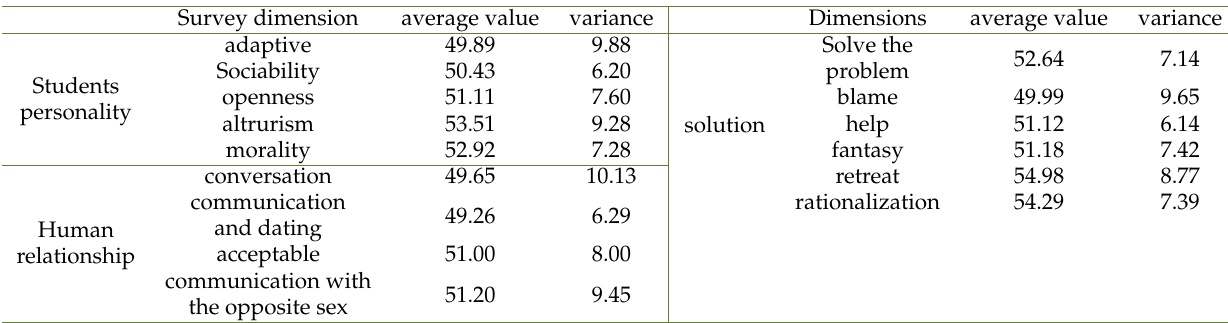
Table 3. Findings of Individual Personality,Diagnosis of Interpersonal Relationships and Coping Styles in Higher Vocational Colleges (N=300).